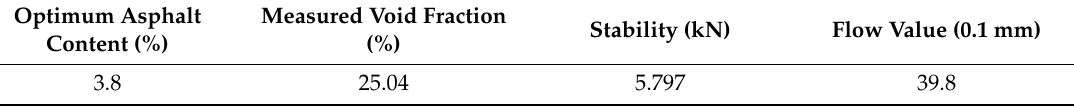
Table 9. Verification results of the mixture ratio of base asphalt mixture.